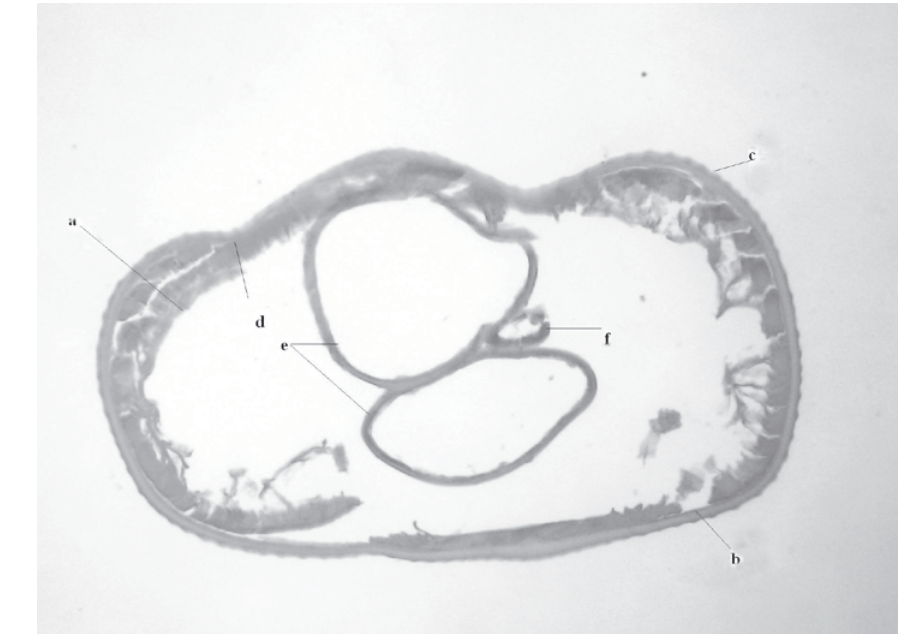
Figure 2. Histological cross-section of the D. repens.